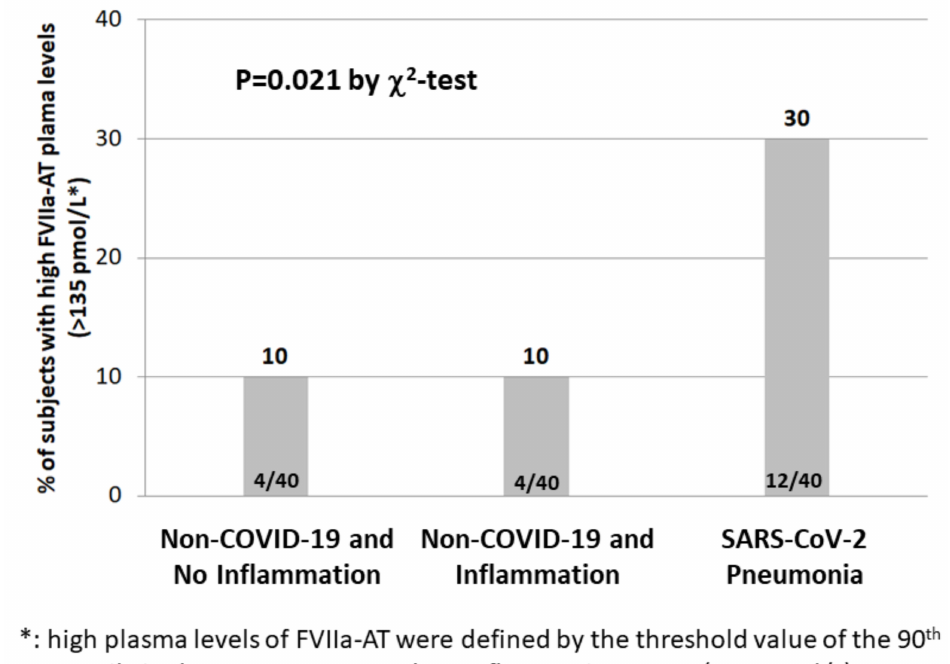
Figure 3. High FVIIa-AT levels in subjects with or without SARS-CoV2 infection. Prevalence of high-activated factor VII–antithrombin complex (FVIIa-AT) plasma levels in the three study